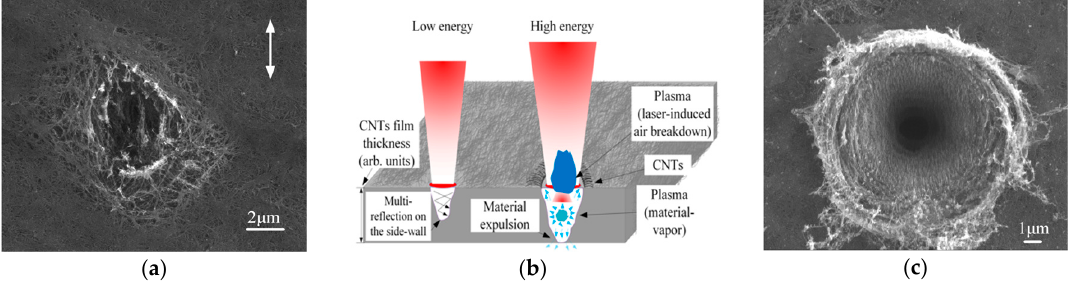
Figure 5. ( a ) Surface morphology of hole under E = 25 nJ ablation; ( b ) schematic illustration on the ablation mechanism with different pulse energies; and ( c ) surface morphology of hole under E = 165 nJ ablation. (The direction of double arrows in the figure is the polarization direction of the laser). When the laser pulse energy was low, the vaporization of the oligomer on the surface of the CNT film occurred during the pulse ablating process. The CNTs and the oligomer at the center of the spot were simultaneously removed due to the Gaussian distribution of laser intensity. However, the lower